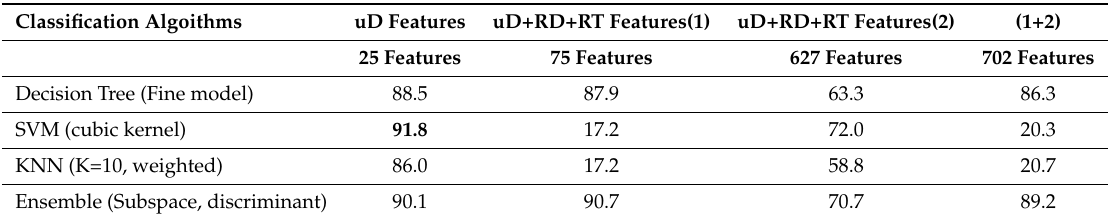
Table 5. Classification results from the multiclass model for different classifiers and combinations of sets of